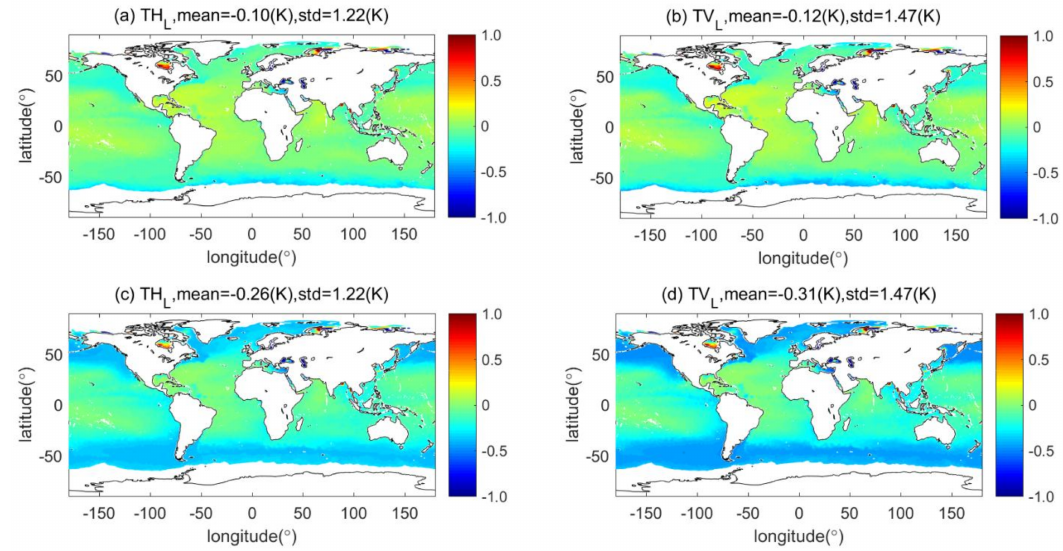
Figure 1. The difference of the TB of flat sea surface with KS, MW and GW dielectric constant models. This is an example of the differences are averaged over one month (August 2012) and in 0.25 ◦ bin in longitude and latitude: ( a , b ) the difference between GW and KS models at 30 ◦ incident angle for H-pol. and V-pol., respectively; and ( c , d ) the difference between GW and MW models at 30 ◦ incident angle for H-pol. and V-pol.,